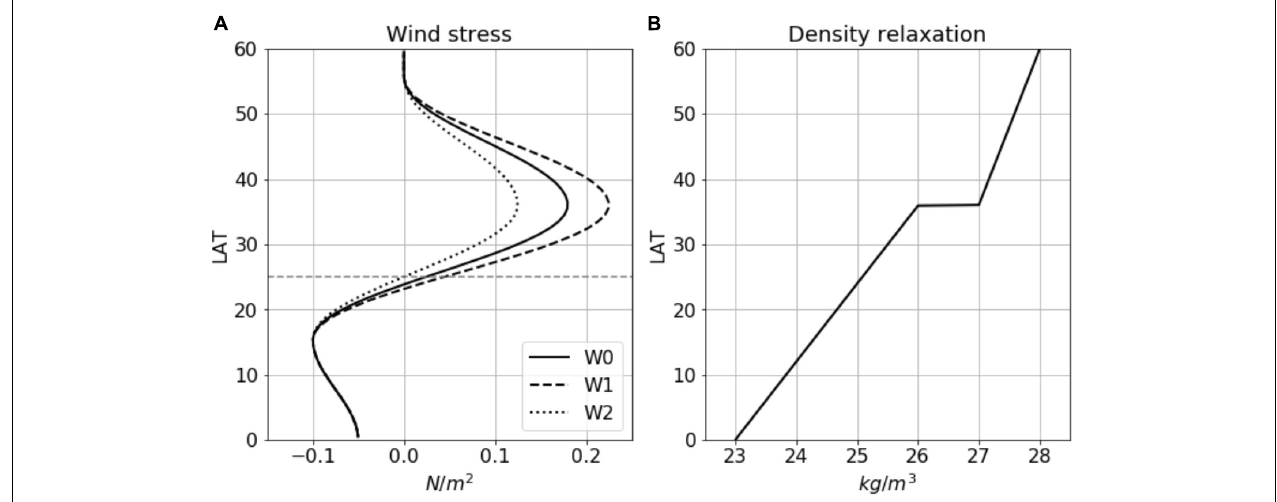
FIGURE 1 | Surface forcing of the model. (A) Zonal wind profiles. The solid line (W0) is the zonal wind used in experiments D1, D3.2, D10, and D32. The other two lines are the zonal wind used in sensitivity experiments. The gray dashed line means the latitude. (B) Restoring sea surface density. A density “jump” at 36 ◦ N is specified to simulate the strong convective overturning poleward of the subtropical front, as in the real ocean.